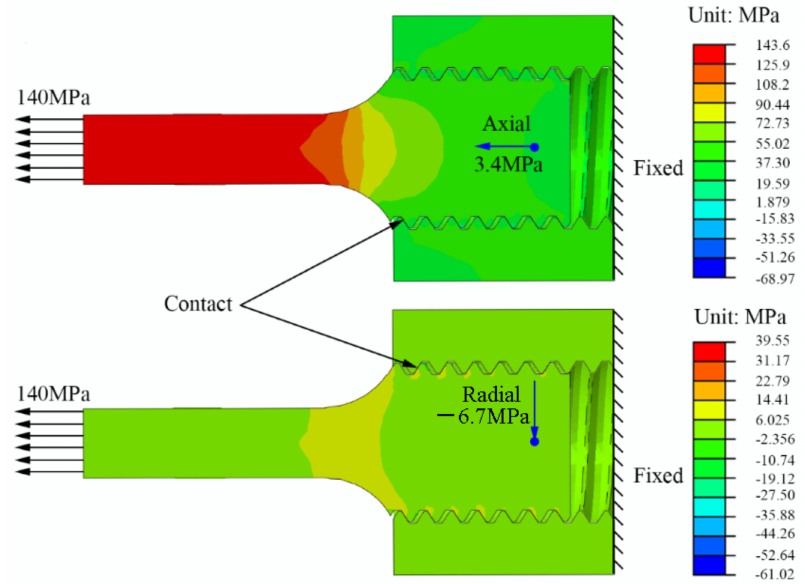
Figure 3. Axial and radial stress of G115 part of creep